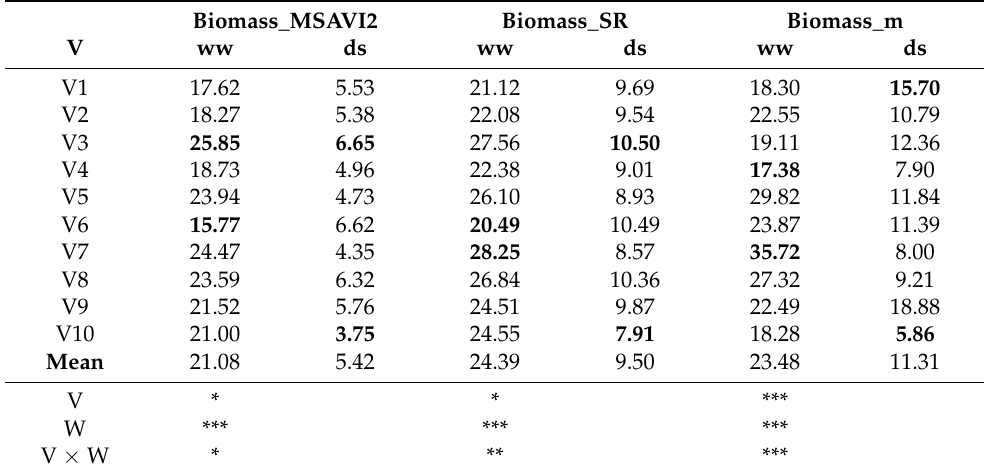
V: variety; W: water regime; ww: well-watered; ds: drought stress; CTVI and NDVI: vegetation index; *** sig- nificant at p < 0.001; ** significant at p < 0.01; * significant at p < 0.05; the bold indicate the highest and lowest value measured. Table 7. ANOVA of the measured biomass per plant (biomass_m) and calculated from vegetation index (biomass_MSAVI2 and biomass_SR) under well-watered and drought stress.